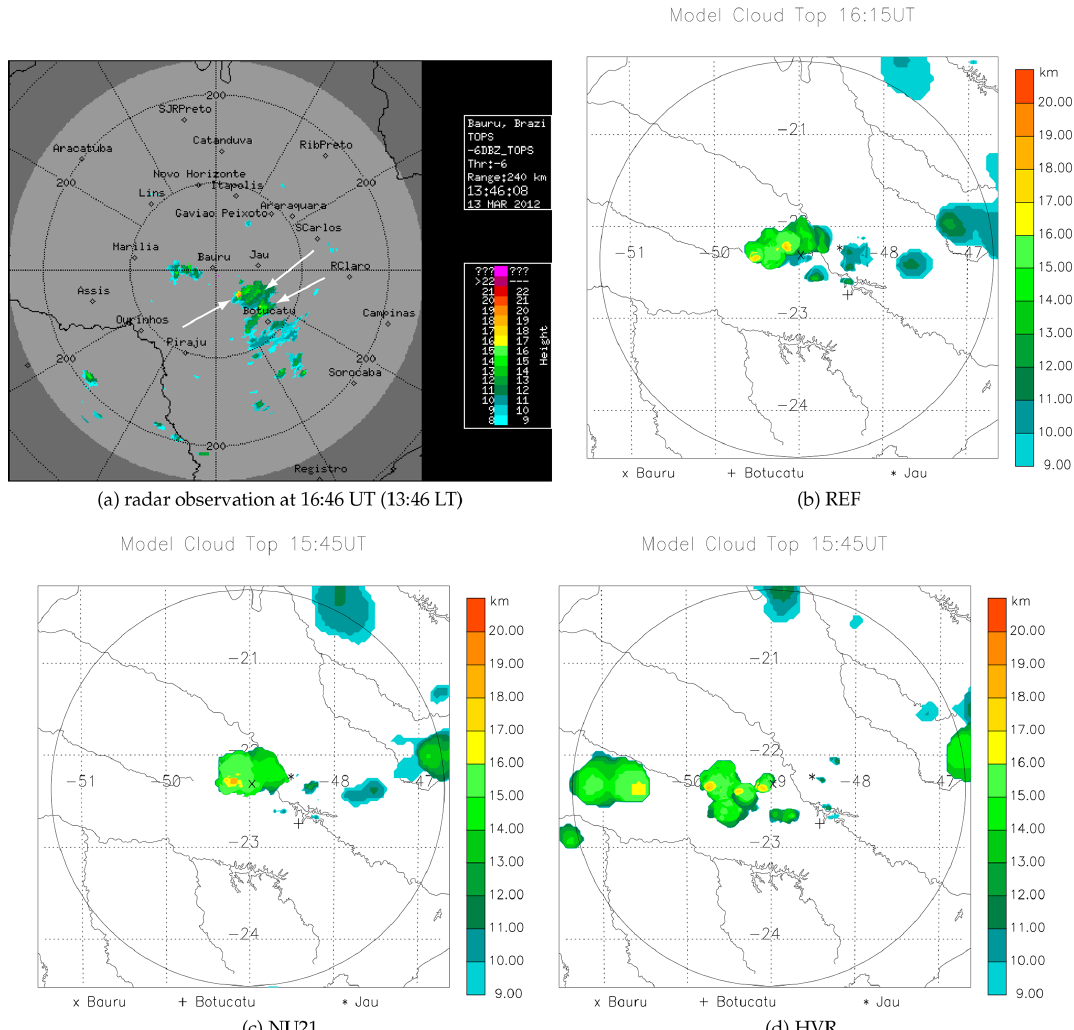
Figure 1. Snapshots of echo tops, observed by the S-band radar and modelled cloud tops from the BRAMS simulations on 13 March 2012, centred at Bauru. (a) Radar observation at 16:45UT, then (b–d) REF at 16:15UT, NU21 at 15:45UT, and HVR at 15:45UT. The circle displayed in panels (b) , (c) , and (d) corresponds to the 240km radar range in (a) . The arrows represent the three deep convective cells that surround Botucatu, one of which has a cloud-top height greater than